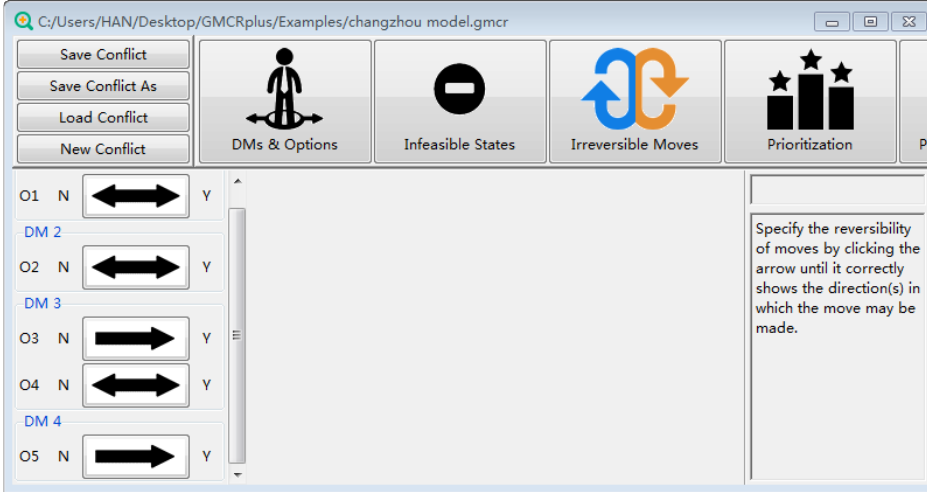
Figure 9. Indication of irreversible